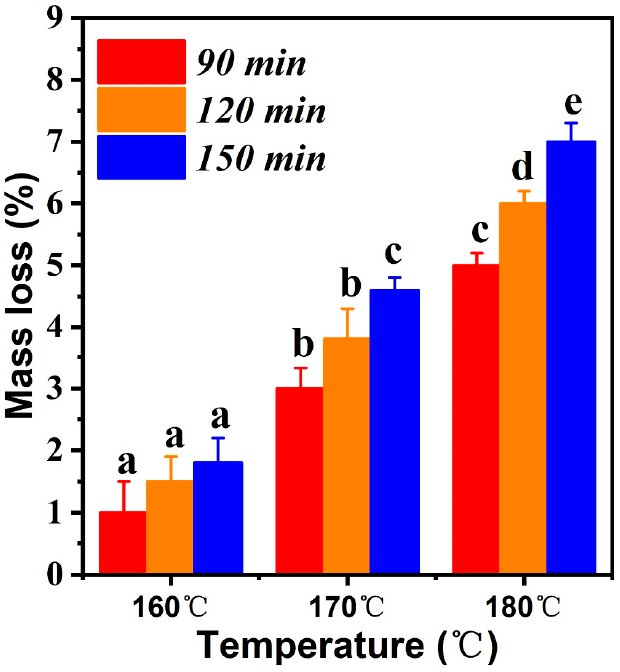
Figure 2. Mass loss (%) of bamboo samples as a function of treatment parameters. The different letters represent significant differences between treatments ( p < 0.05).